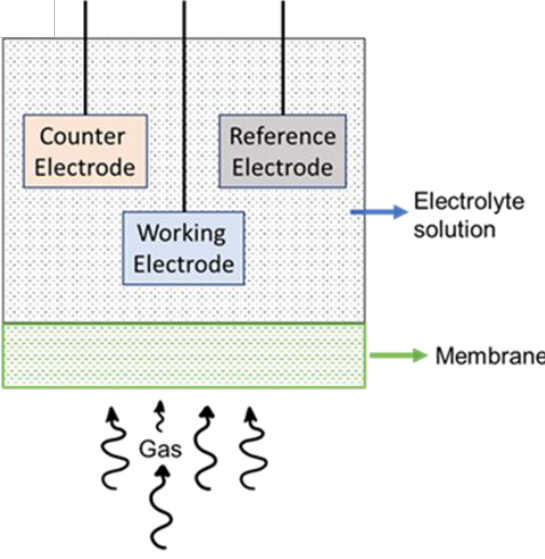
Figure 1. Basic design of a three-electrode Clark-type amperometric gas sensor. The gas flowing from the environment toward the electrochemical cell is filtered by a membrane. As the analyte molecules enter the electrochemical cell, they are solvated by the electrolyte and diffuse into the medium. The solvated molecules that are adsorbed on the working electrode and that pass an additional liquid-phase barrier react with a suitably polarized working electrode and react with it via oxidation or reduction. The counter reaction occurs at the counter electrode, allowing the charge conservation and the flow of current. A third electrode is usually employed as a potential